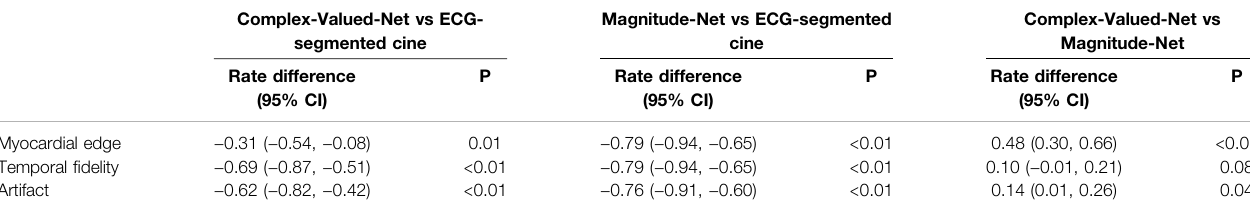
TABLE 1 | Differences in percentage of two grades (1 – 3 and 4 – 5) of image quality scores between three methods. Complex-Valued-Net vs ECG- segmented cine